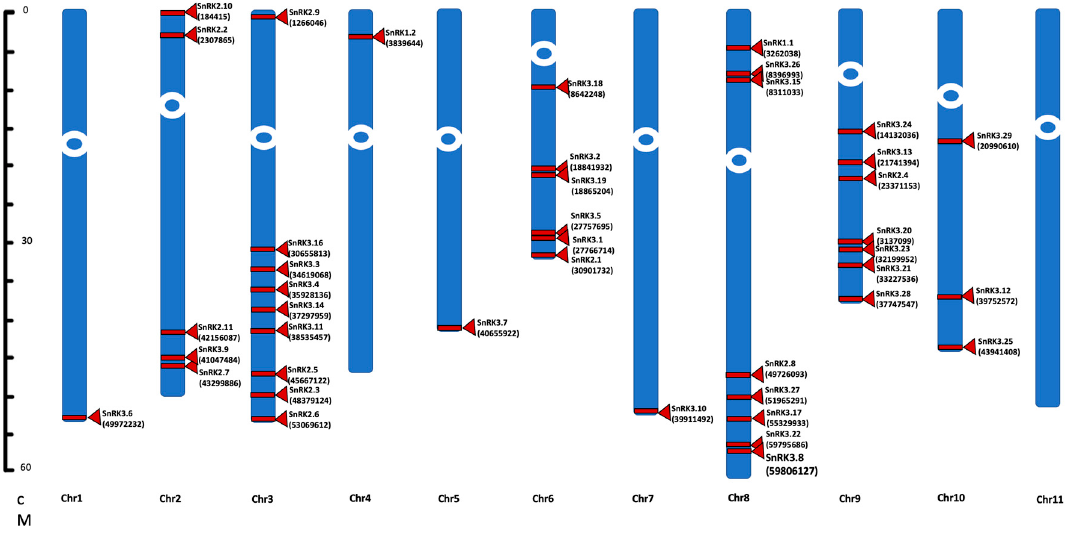
Figure 2. Chromosomal localization of the SnRK genes. The sequences of 42 genes of SnRK genes were identified on P. vulgaris genome. The chromosomes are represented by the numerically distributed blue bars. Red bands and triangles indicate the location of each gene on the chromosome. The numbers in the parenthesis represent the start site of the individual SnRK gene location on the P. vulgaris genome.